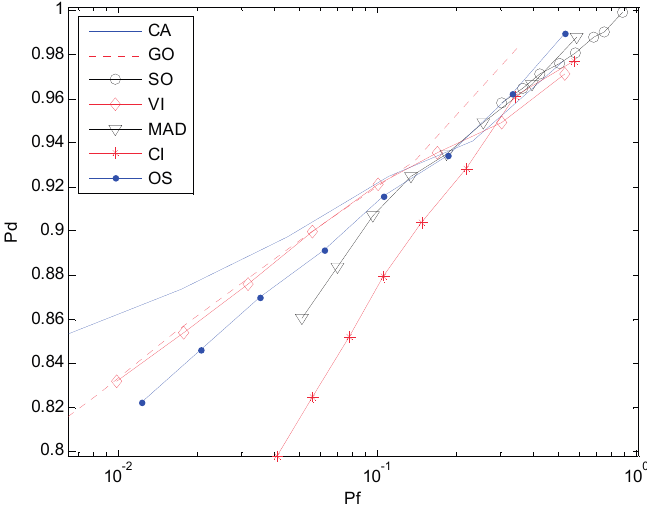
vs . P (ROC) in clutter edge environment. f d